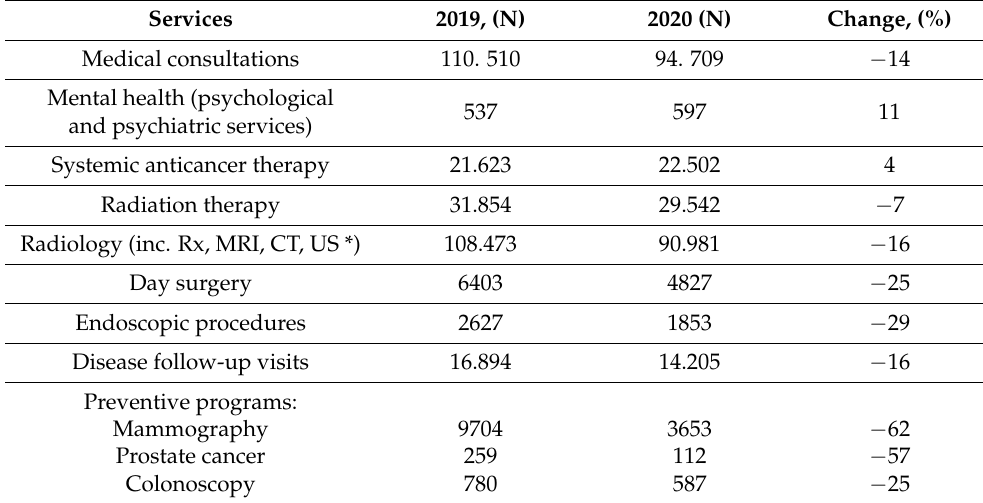
Table 1. Summary of out-patient services at